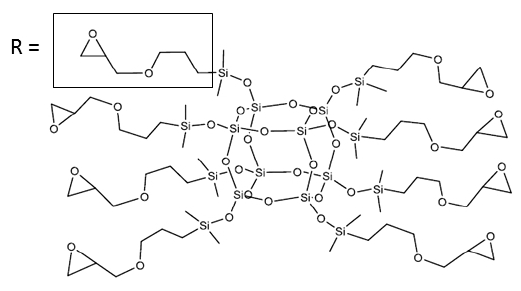
Figure 1. Chemical structure of the octakis[(3-glycidoxypropyl)dimethylsiloxy]octasilsesquioxane (GPOSS).